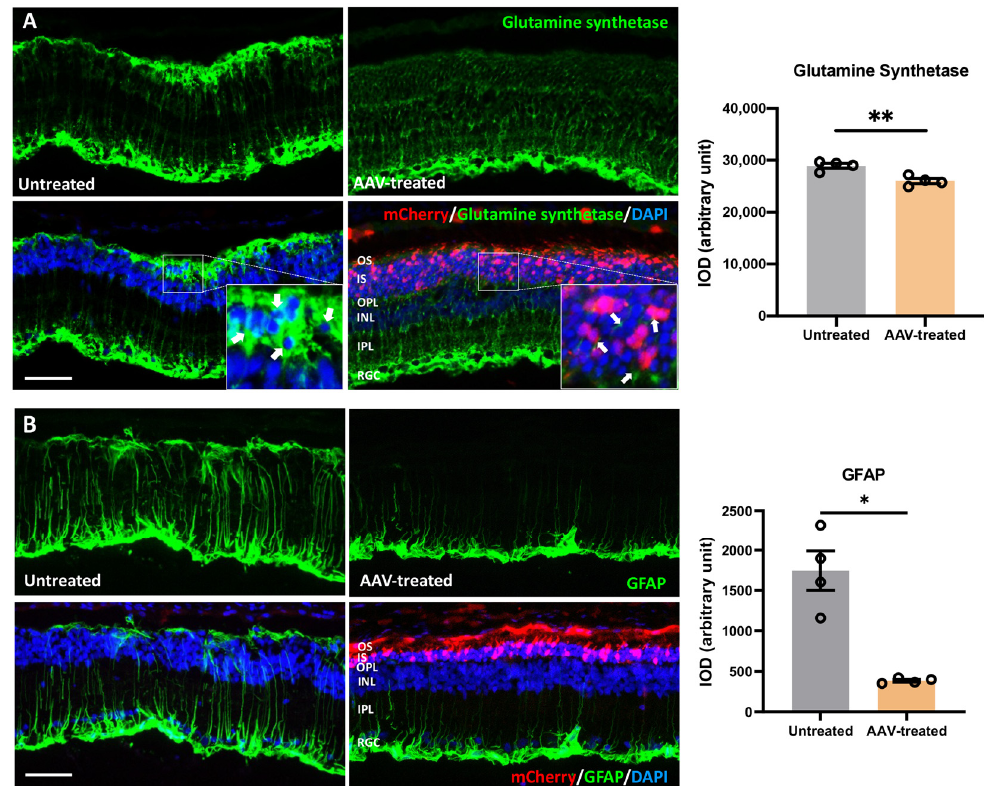
Figure 6. m- Rho P23H ablation preserved retinal morphology and prevented Müller glia activation. ( A ) The areas within the retinas distal to the injection site had thick and elongated processes of Müller glia (green: GS + ) that spanned the ONL and surrounded condensed nuclei (DAPI), consistent with degenerating photoreceptors (arrows). AAV-treated retina shows normal morphology of Müller glia with single and thin processes that only span the ONL. ( B ) Retinal regions distal to AAV injection show significantly increased GFAP immunoreactivity (green) indicative of activated Müller glia, a hallmark of Müller cell gliosis. The number of active Müller glia was reduced significantly from AAV treatment, indicated by decreased GFAP expression that was restricted to end feet. Scale bar, 100 μ m. Nuclei were stained with DAPI. INL, inner nuclear layer; IS, inner segment; ONL, outer nuclear layer; OS, outer segment; PR, photoreceptor; RGC, retinal ganglionic cell. Data represent the mean ± SEM ( n = 4). * p ≤ 0.05, ** p ≤ 0.01 .